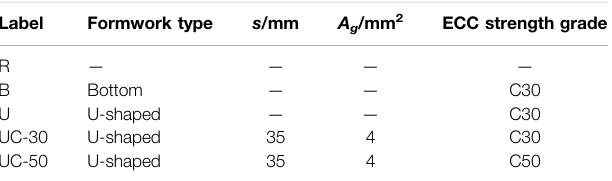
TABLE 1 | Test matrix of the composite beams.